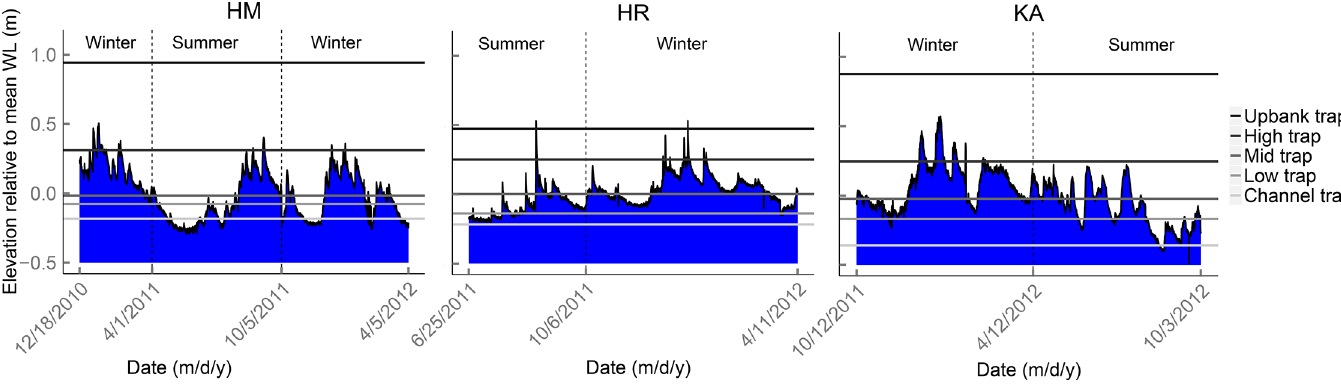
Fig 2. Water level fluctuations relative to the mean water level during the sampling periods for the Hagmolenbeek (HM), Hooge Raam (HR) and Kleine Aa (KA). Samplingperiods are separated by vertical dotted lines. Seed trap elevation(relative to mean water level) of representative transects are indicatedby